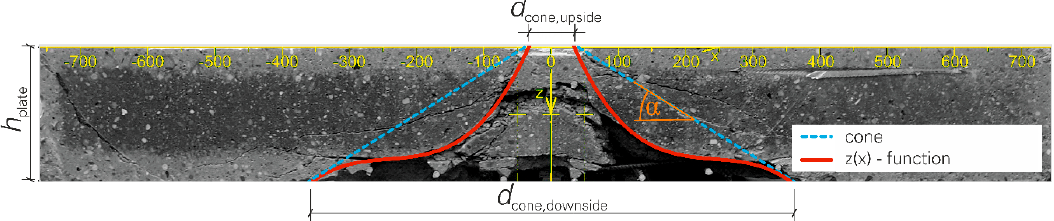
Figure 8. Fracture body due to punching shear failure; real cone and cubic function in comparison; graphic: Hering [17].